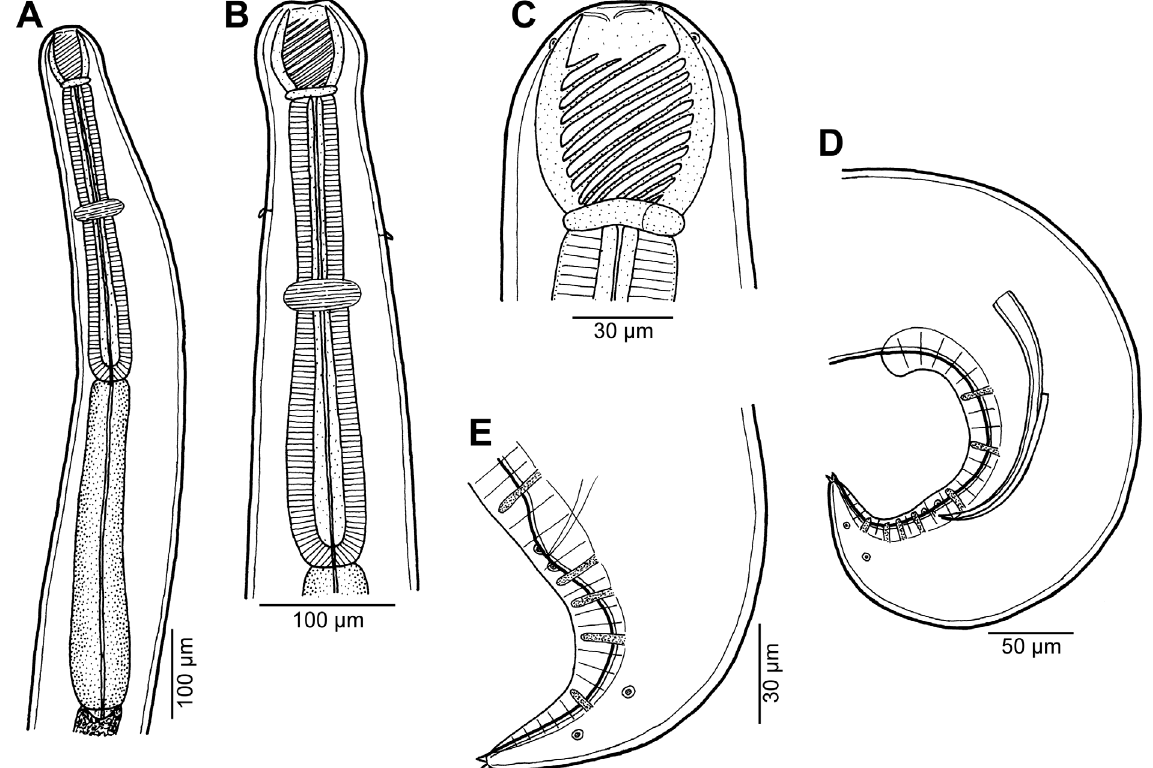
Figure 12. Procamallanus ( Spirocamallanus ) sp. 1 from Carangoides dinema , male. (A, B) Anterior end, lateral and dorsoventral views, respectively; (C) buccal capsule, lateral view; (D) posterior end of body, lateral view; (E) tail, lateral